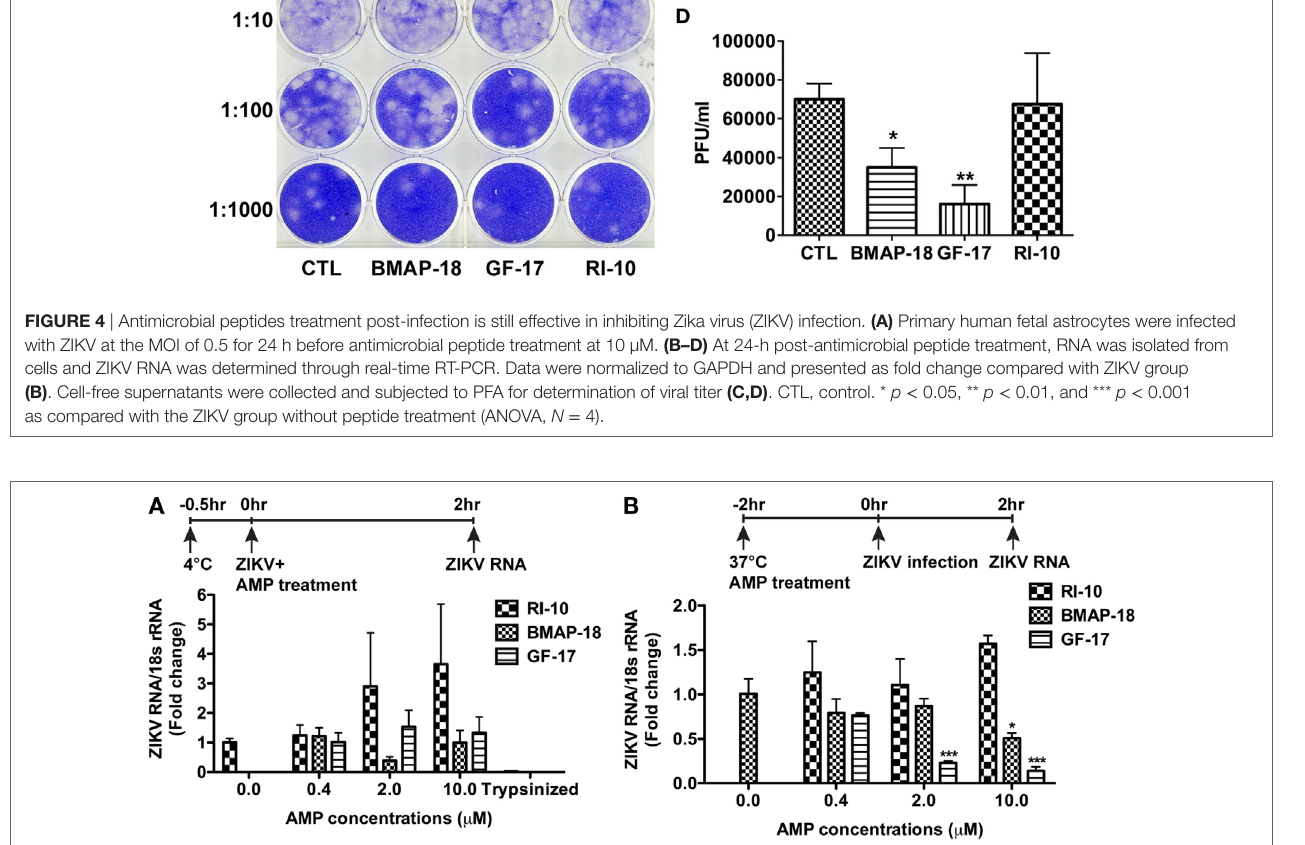
FigUre 5 | Antimicrobial peptides do not affect Zika virus (ZIKV) viral attachment but inhibit early ZIKV infection. (a) Primary human fetal astrocytes were pre-incubated at 4°C for half an hour and then treated with antimicrobial peptides along with ZIKV infection at the MOI of 0.5 for 2 h. Cultures were then washed with fresh medium for three times. ZIKV RNA was determined through real-time RT-PCR in total cellular RNA. Data were normalized to 18-s rRNA and presented as fold change compared with the ZIKV group. The trypsin digestion group readily removes any attached virions and thus serves as positive control. (B) Primary human fetal astrocytes treated with antimicrobial peptides for 2 h at 37°C then infected with ZIKV at the MOI of 0.5. After infection for 2 h, cultures were washed with fresh medium for three times and RNA was isolated from whole cells. ZIKV RNA was determined through real-time RT-PCR. Data were normalized to 18-s rRNA and presented as fold change compared with ZIKV group. * p < 0.05 and *** p < 0.001, as compared with the ZIKV group without peptide treatment (ANOVA, N = 3).